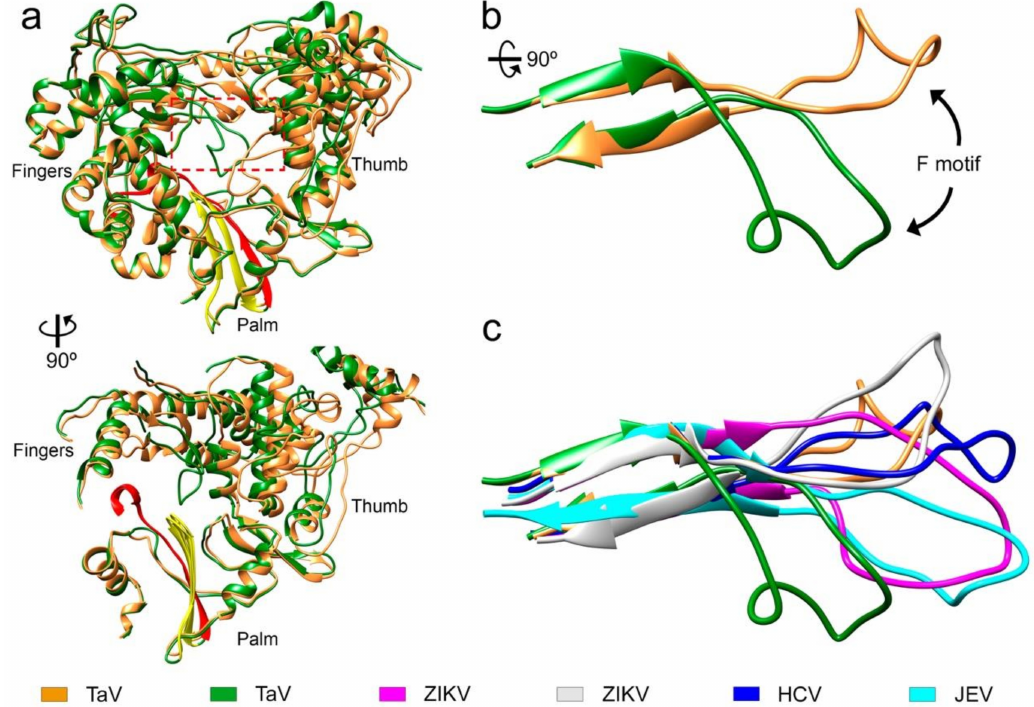
Figure 5. Conformational changes in the motif F of TaV pol. ( a ) Front and side views of the overall structure of the TaV RdRP, found both in the unbound-form and in the RNA catalytic complexes (orange ribbons). The structure of a new conformation of the unbound enzyme, exhibiting a large rearrangement of motif F is superimposed (green ribbons) The large movement of motif F is also accompanied by a significant rotation of the thumb subdomain. Structural motif A and C in the palm subdomain are highlighted in red and yellow respectively. ( b ) Close up views of the TaV pol motif F superimposition. ( c ) Structural variability of motif F in TaV pol compared to different members of the Flaviviridae family: HCV (dark blue; PDB id: 4WTA), ZIKV position 1 (grey; PDB id: 6I7P), ZIKV position 2 (magenta; PDB id: 5UOC) and JEV (cyan; PDB id: